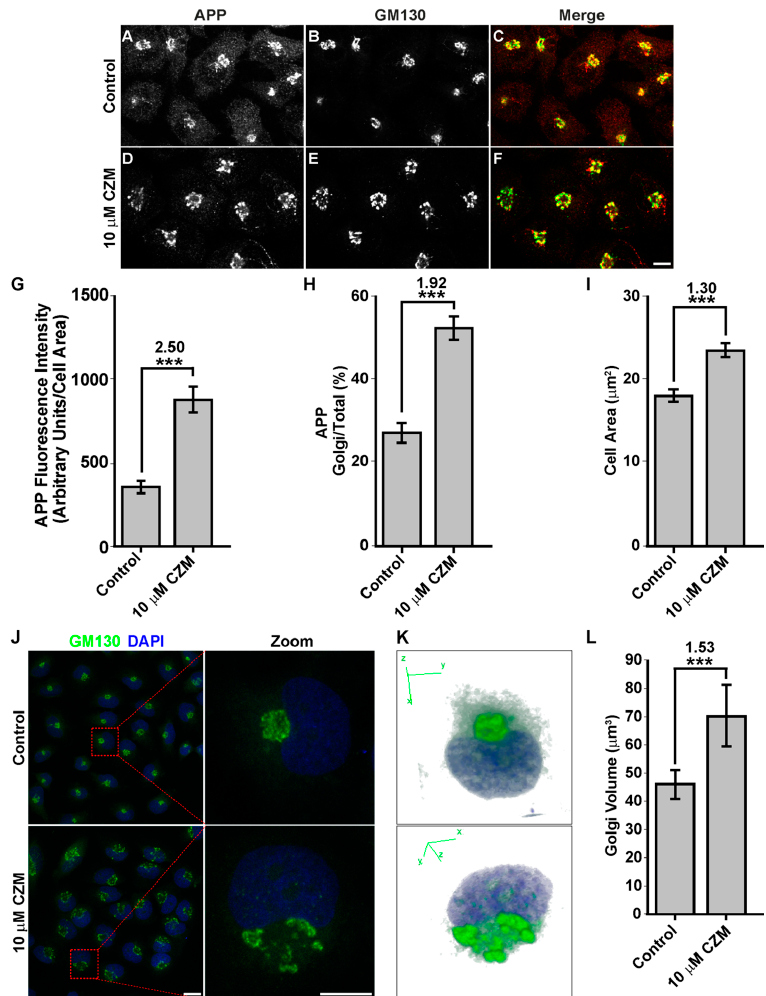
Figure 4. Acute inhibition of PSMD14 by CZM triggers the accumulation of APP in a swollen Golgi apparatus. Immunofluorescence analysis of endogenous APP in H4 parental cells treated either with the vehicle (DMSO; Control) ( A – C ) or CZM ( D – F ) for 4 h. Cells were fixed, permeabilized, and double stained with a rabbit polyclonal antibody to APP (CT695) ( A , D ) and a mouse monoclonal antibody to GM130 (clone35 / GM130) ( B , E ), followed by Alexa-594-conjugated donkey anti-Rabbit IgG and Alexa-488-conjugated donkey anti-Mouse IgG. Merging of the images generated the third picture ( C , F ). Scale bar, 10 mm. ( G ) Quantitative analysis of the mean of total fluorescence intensity of APP upon treatment with CZM, in comparison to control cells. The statistical significance was determined by Student’s t-test. Bars represent the mean ± SD of the fluorescent signal per cell area ( n = 43 cells). *** p < 0.001. ( H ) Quantitative analysis of the fraction of APP colocalizing with GM130 under CZM treatment and compared to control cells. Statistical significance was determined by Student’s t-test. Bars represent the mean ± SD of the fluorescent signal per cell area ( n = 43 cells). *** p < 0.001. ( I ) Quantitative analysis of the cell area. Statistical significance was determined by Student’s t-test. Bars represent the mean ± SD of the cell area ( n = 43 cells) ** p < 0.001. ( J ) Immunofluorescence microscopy analysis of GM130 in parental H4 cells treated either with the vehicle (DMSO; Control) or CZM for 4 h. Cells were fixed, permeabilized and stained with mouse monoclonal antibody to GM130 (clone 35 / GM130) followed by Alexa-488-conjugated donkey anti-mouse IgG, and nuclei were stained with DAPI. Scale bar, 10 µ m. ( K ) 3D reconstructions of the Golgi apparatus using GM130 as Golgi marker were generated from Z-stacks (250 nm). ( L ) Golgi Volume was measured from 3D reconstructions as shown in ( K ). Statistical significance was determined by Student’s t-test. Bars represent the means ± SEM ( n = 20 cells). *** p <